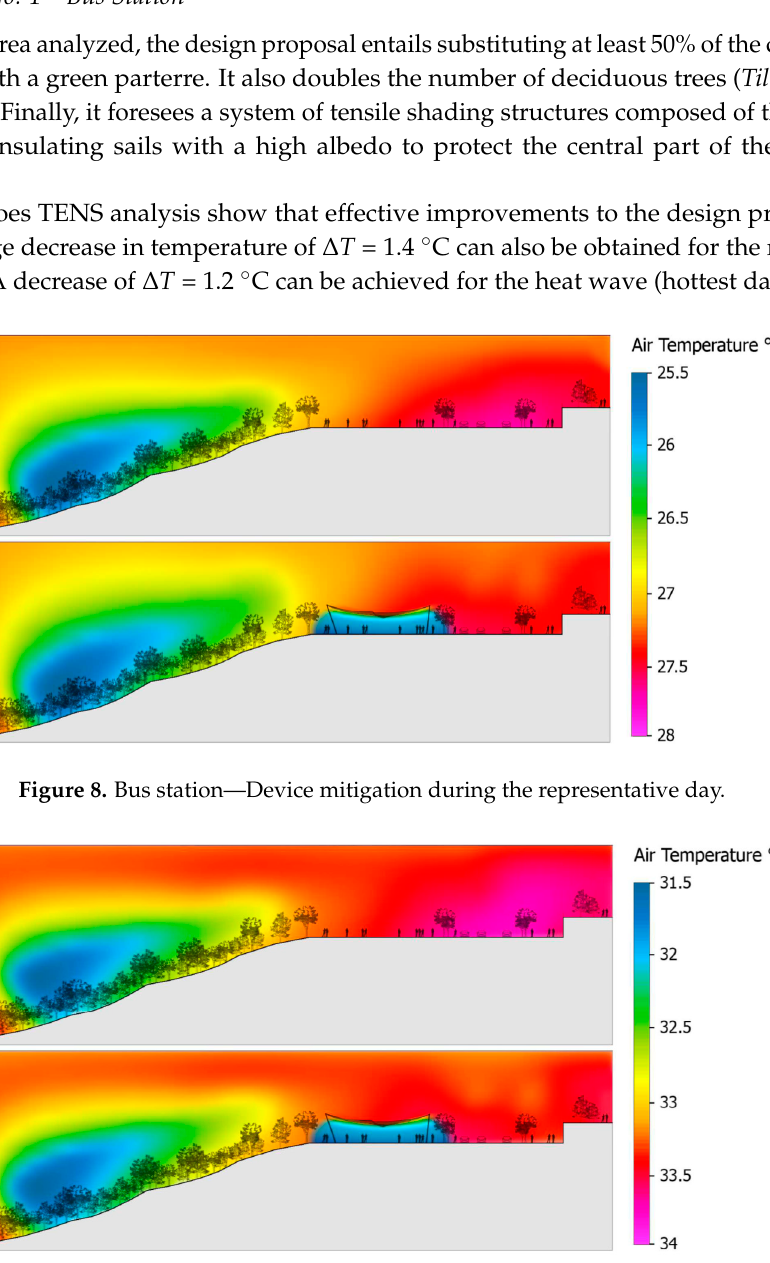
Figure 9. Bus station—Device mitigation during the hottest day.